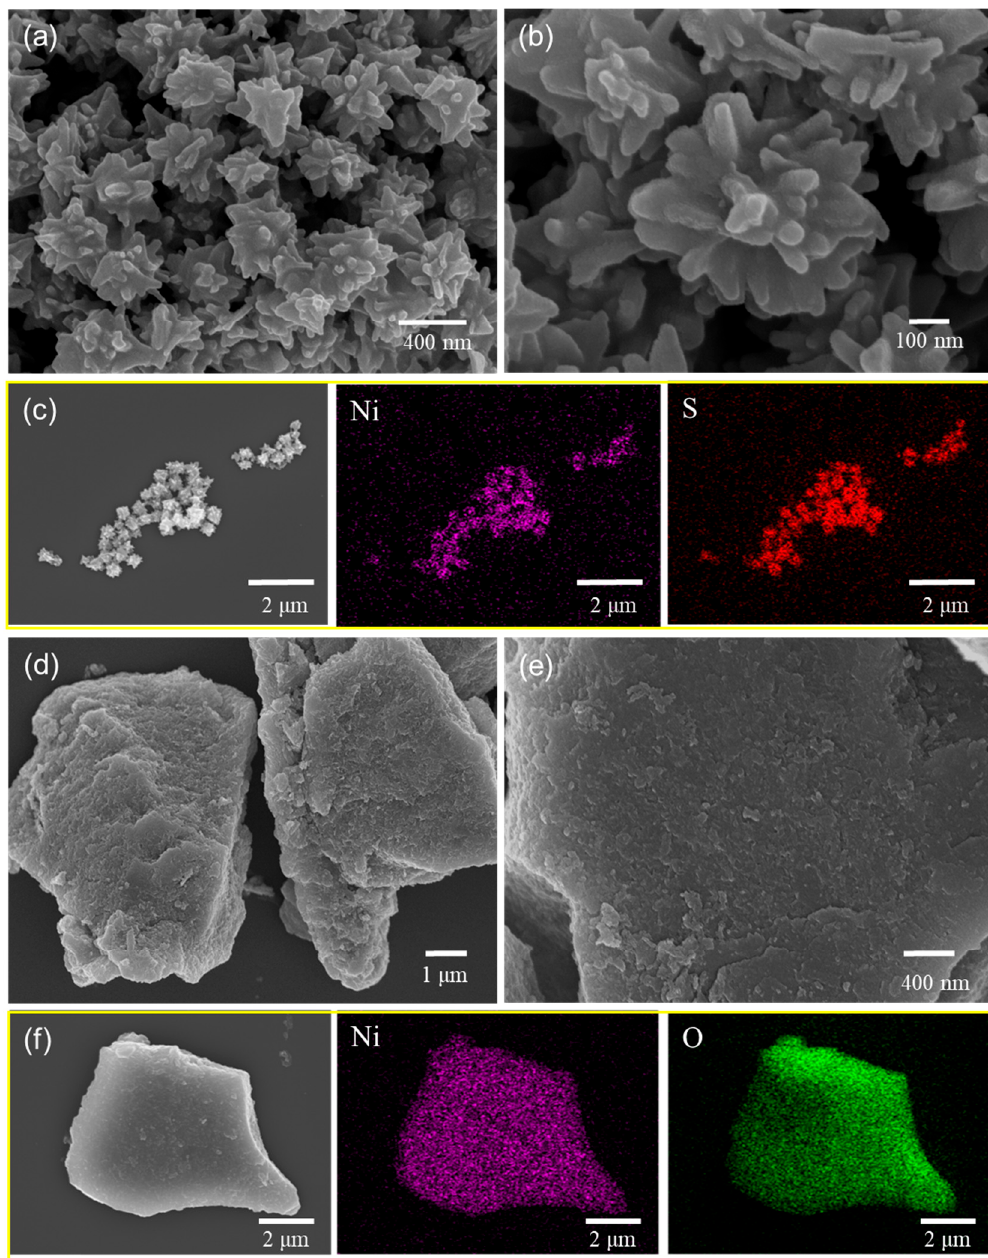
Figure 2. SEM images of ( a , b ) NiS and ( d , e ) Ni(OH) 2 ; elemental mapping images of ( c ) NiS and ( f ) Ni(OH) 2 .